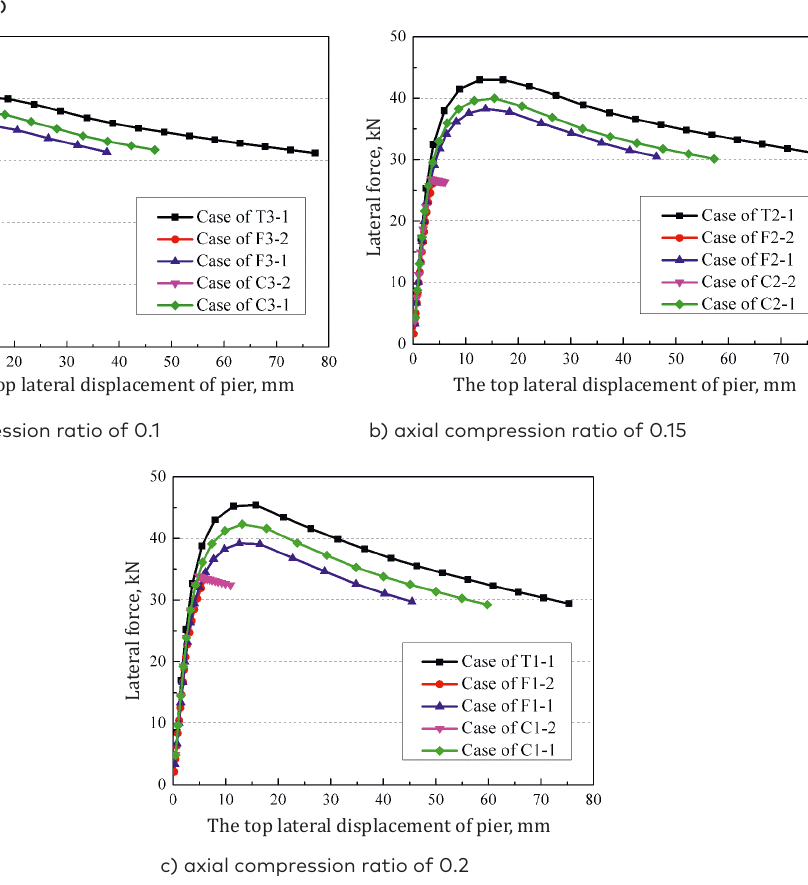
Figure 11. Comparisons of horizontal force-displacement curves of the